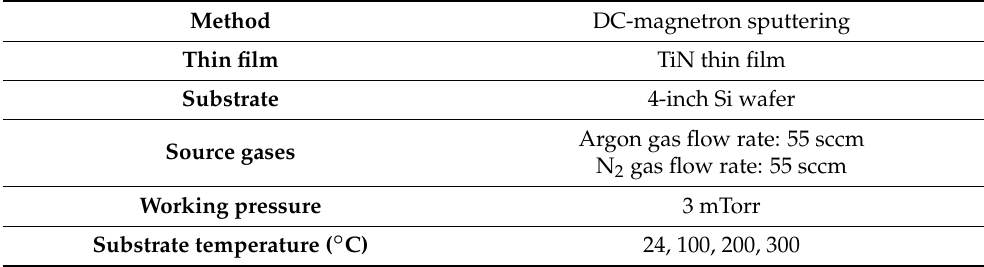
Table 1. Process conditions for TiN thin